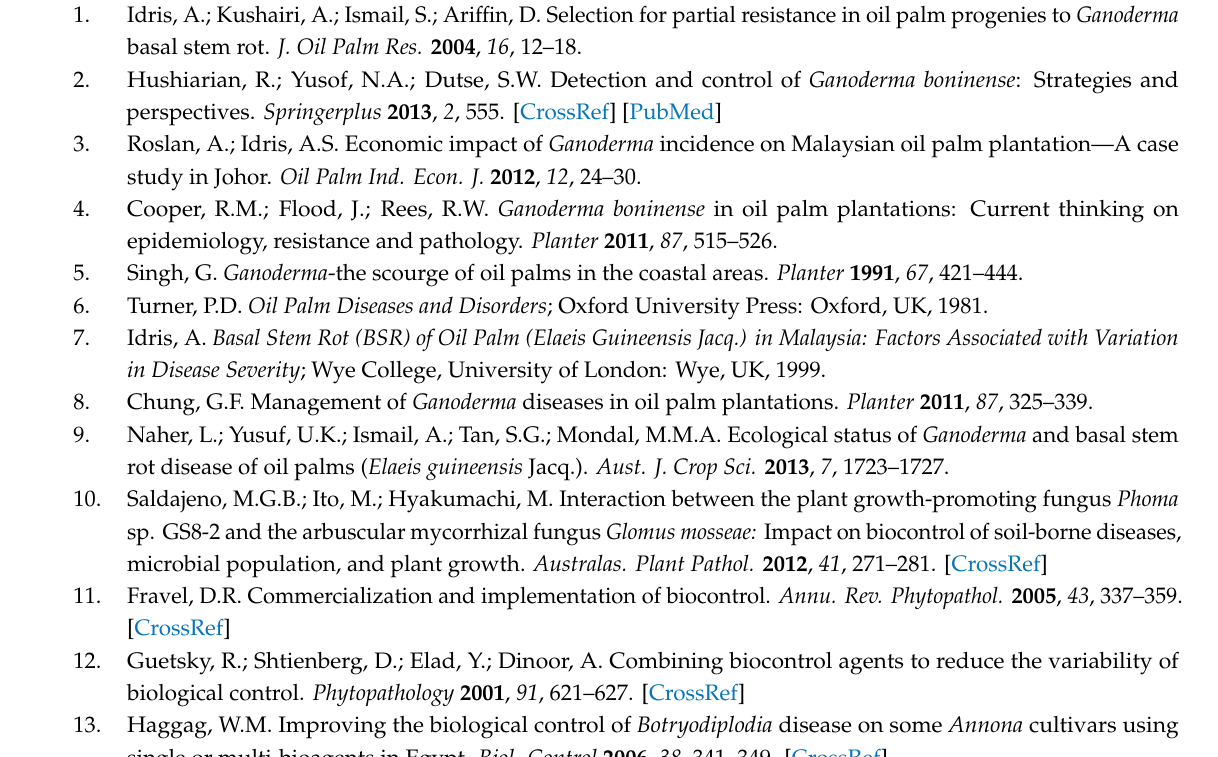
Table S1: Soil chemical parameters for Bungor soil series used for nursery